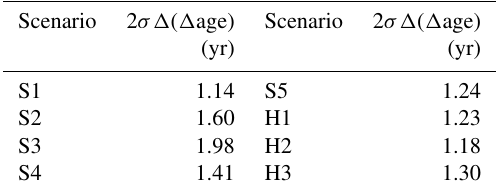
Table 5. Final mismatches (cid:49) ( (cid:49) age) (2 σ ) of (cid:49) age between the cor- rected solution and the synthetic targets for all